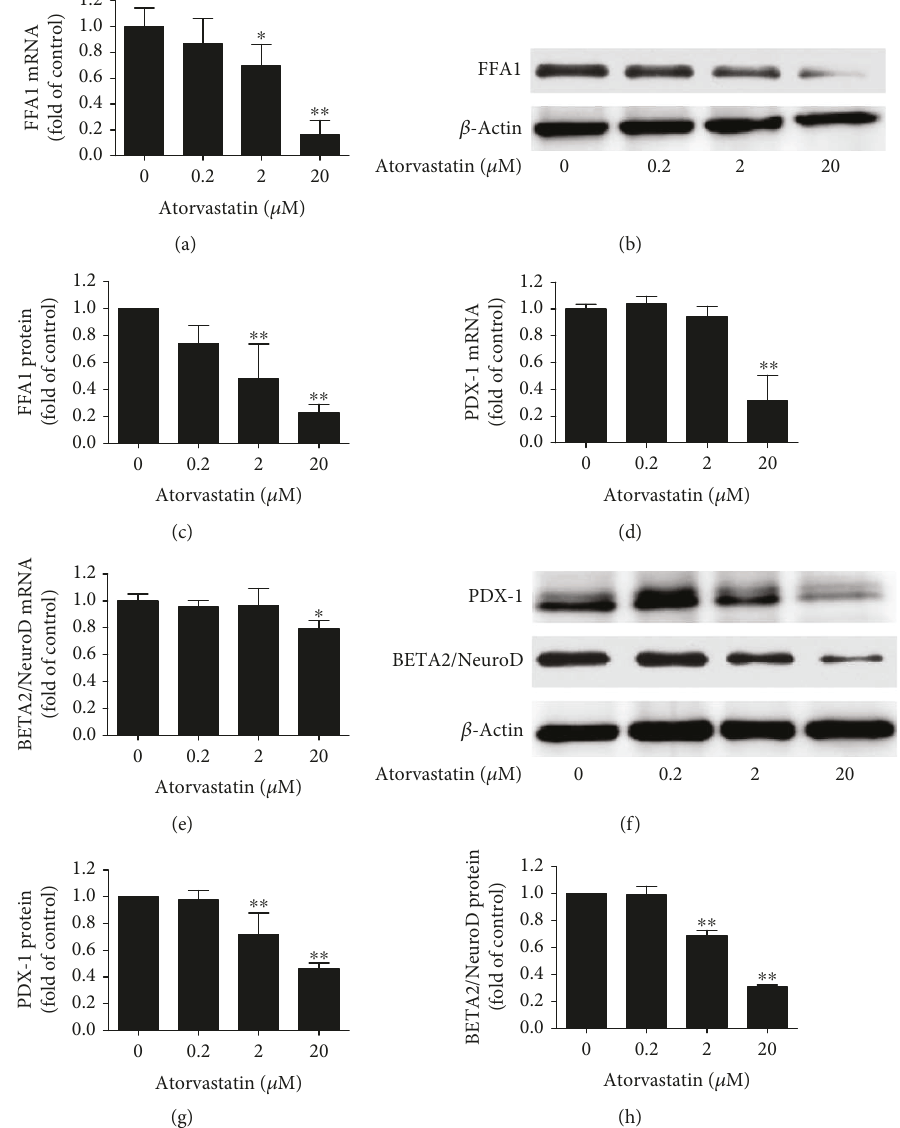
Figure 2: E ff ect of atorvastatin on the expression of FFA1, PDX-1, and NeuroD in INS-1 cells. (a) qRT-PCR assay analysis of FFA1 expression in INS-1 cells treated with di ff erent concentrations of atorvastatin for 24 h. (b and c) Western blot assay analysis of FFA1 expression in INS-1 cells treated with di ff erent concentrations of atorvastatin for 24h. (d) qRT-PCR assay analysis of PDX-1 expression in INS-1 cells treated with di ff erent concentrations of atorvastatin for 24h. (e) qRT-PCR assay analysis of BETA2/NeuroD expression in INS-1 cells treated with di ff erent concentrations of atorvastatin for 24 h. (f, g, and h) Western blot assay analysis of PDX-1 and BETA2/NeuroD expression in INS-1 cells treated with di ff erent concentrations of atorvastatin for 24 h. β -Actin was detected as control. Each experiment was repeated at least three times. ∗ P < 0 05 and ∗∗ P < 0 01 compared to 0 μ M atorvastatin